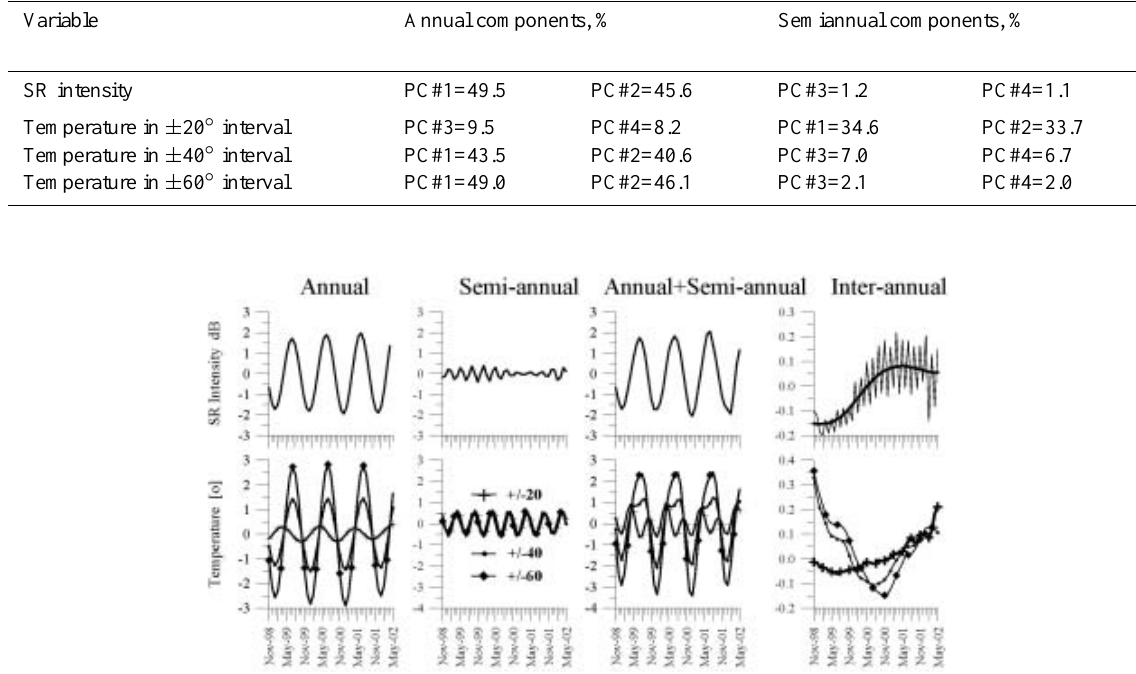
Fig.6. Principal components : annual, semi-annual, annual + semi-annual, and interannual. The upper plots refer to the variations of the Schumann resonance intensity, and the lower plots demonstrate the variations of the global soil temperature in different latitude intervals.